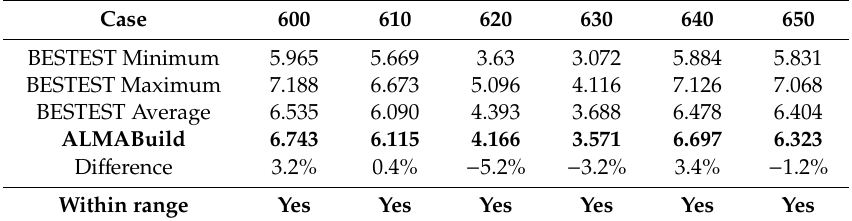
Table 8. Annual Cooling Peak (kW) obtained for non-free-float lightweight BESTEST cases compared with the minimum and maximum threshold values indicated by BESTEST.